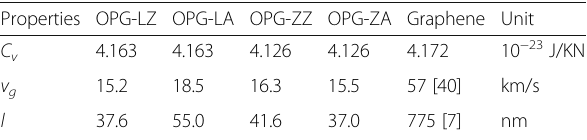
Table 1 Three parameters, heat capacity C v , effective phonon group velocity v g , and phonon mean free path l , of these two carbon allotropes and graphene. N is the total number of atoms in the sample